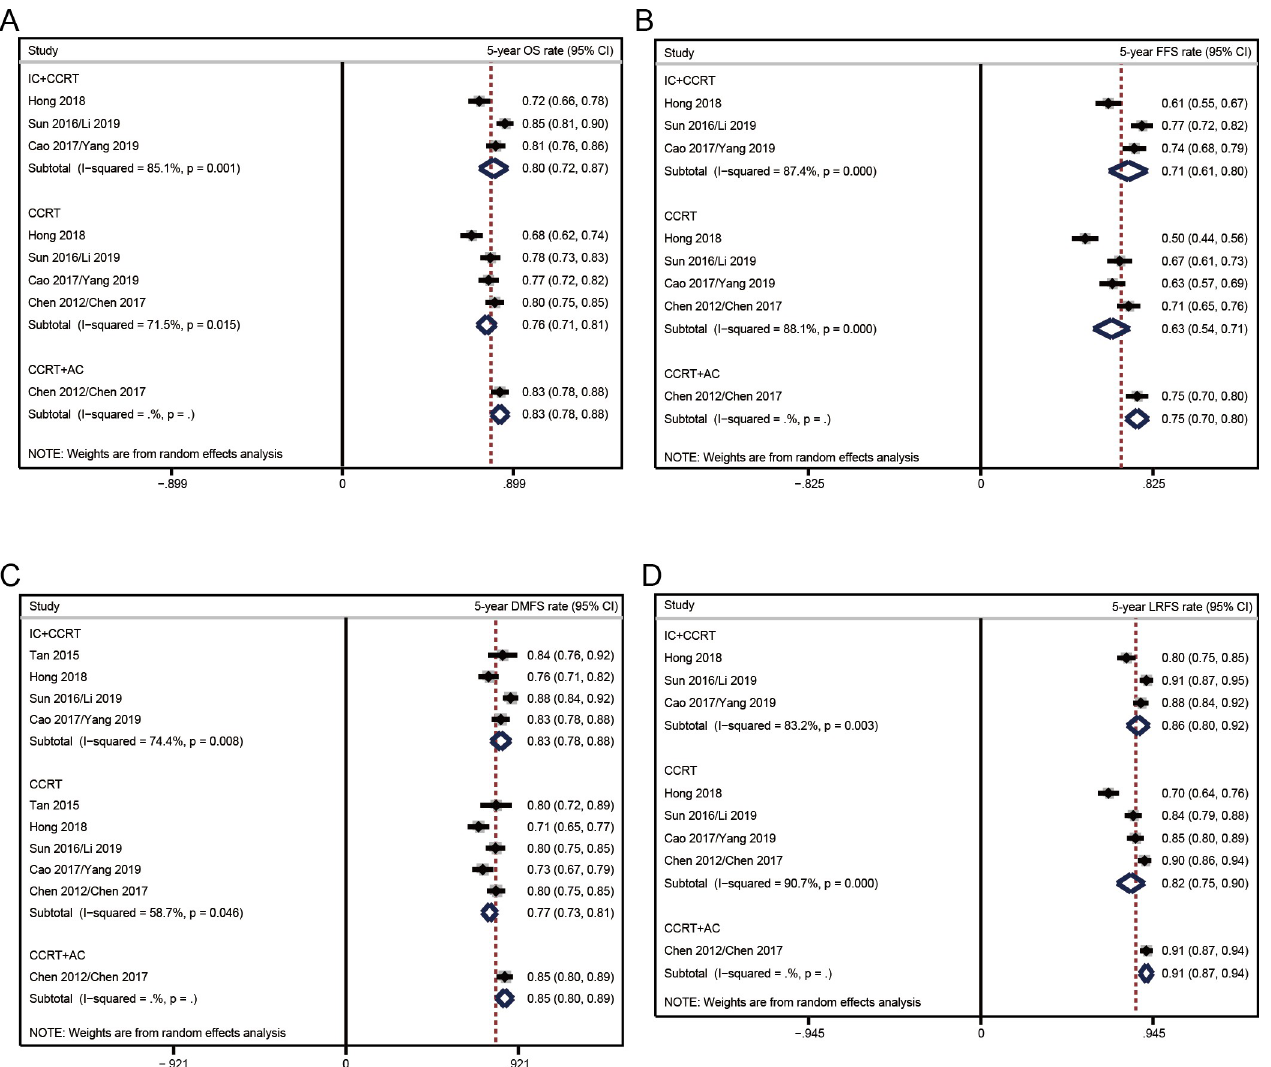
Fig 4. Pooled results of single-arm data for each therapeutic strategy. (A) 5-year overall survival; (B) 5-year failure-free survival; (C) 5-year distant metastasis-free survival; (D) 5-year locoregional recurrence-free survival. A dotted line indicated the survival rate analyzed from all the data included in that